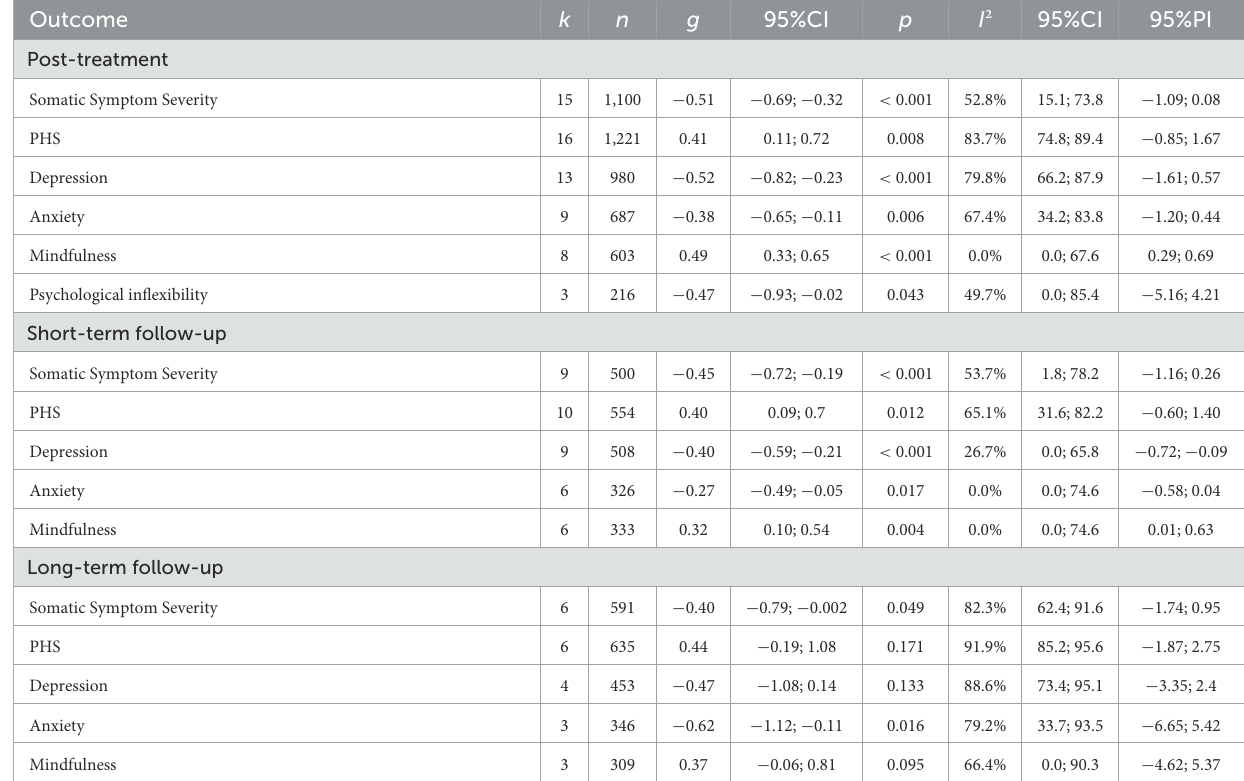
TABLE 1 Treatment